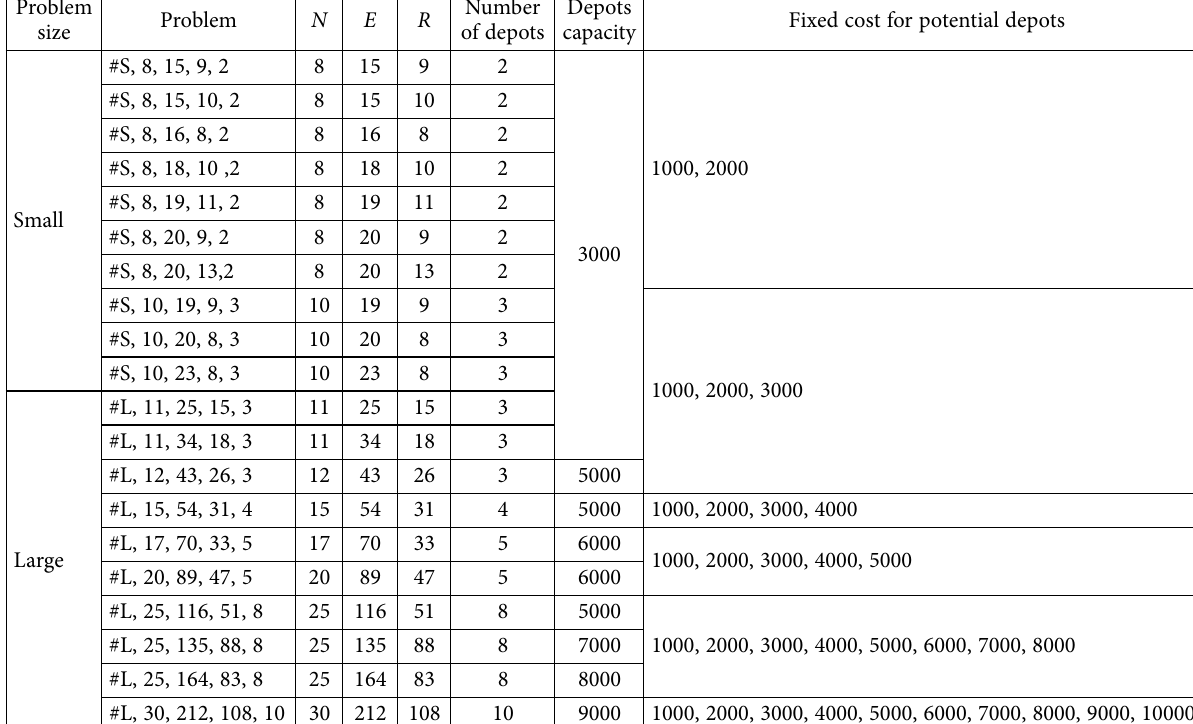
Table 3. Properties of randomly generated instances